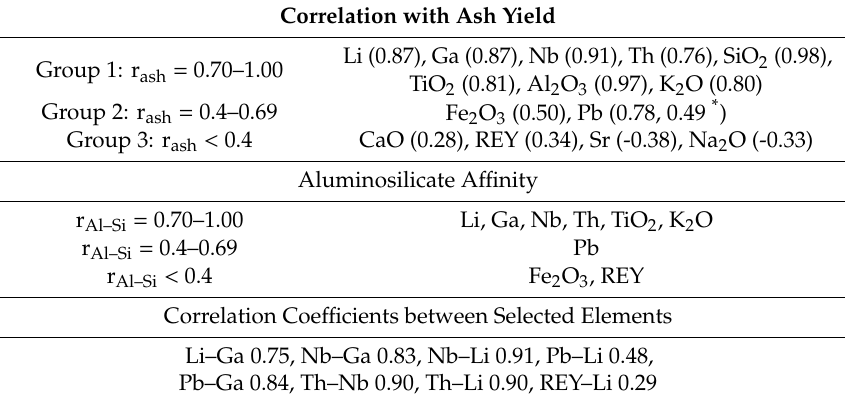
Table 7. Element a ffi nities between the concentrations of elevated elements and the ash yield or selected elements in coal